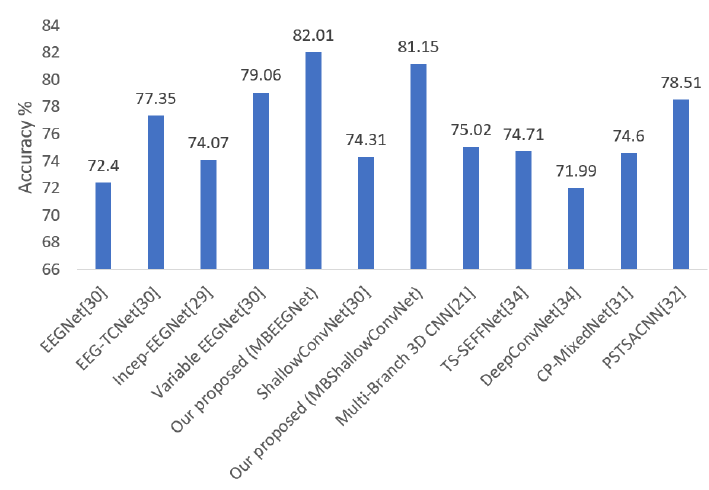
Figure 7. Average classification accuracy on the MI BCI IV-2a dataset.